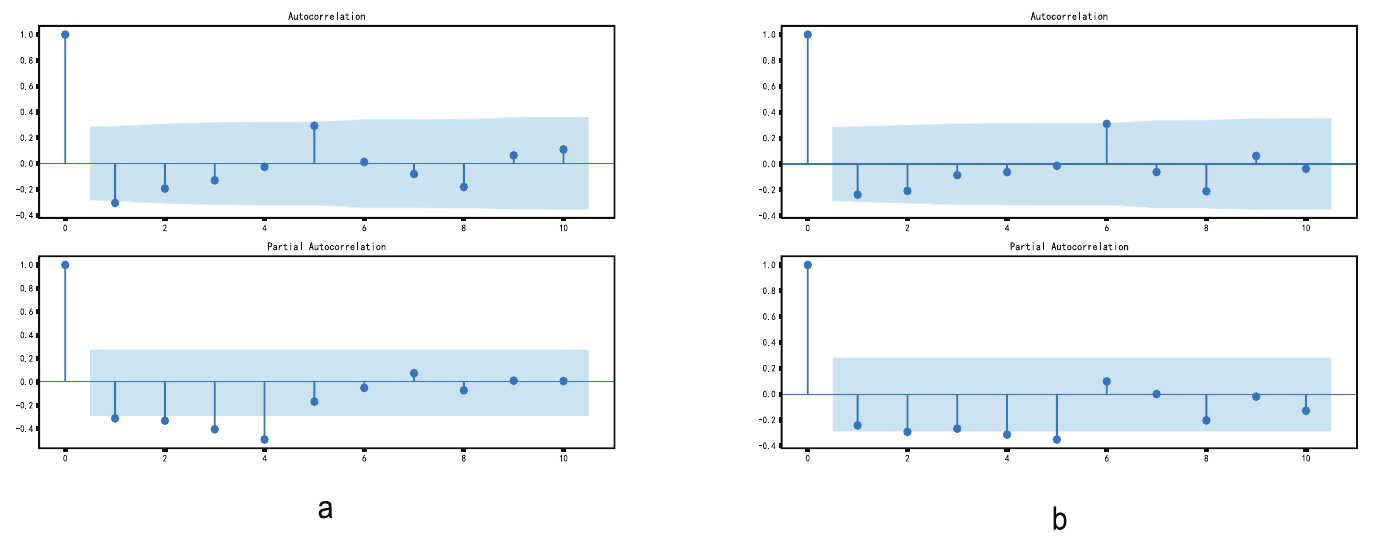
Fig 22. Residual autocorrelation diagram and partial autocorrelation diagram of ARIMA (0,1,1) (a) and ARIMA (4,1,0) (b).